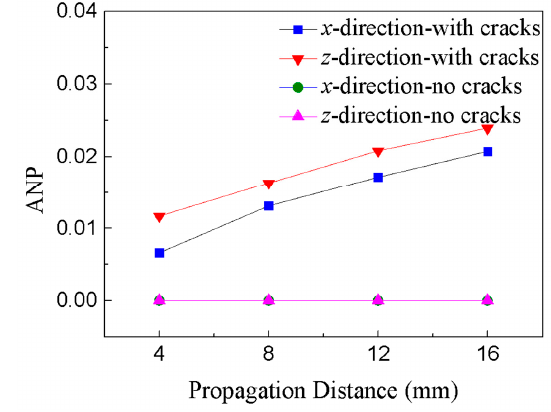
Figure 11. ANP (collected at position 2) versus the propagation distance.